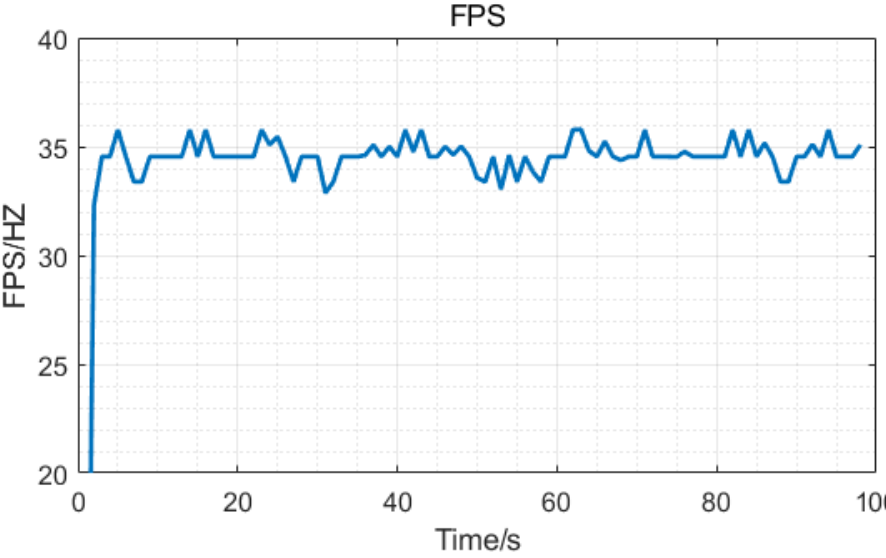
better. In addition, compared with the YOLOv4 algorithm, which is combined with channel attention [30], although the AP of ours decreased a little, the FPS increased significantly.